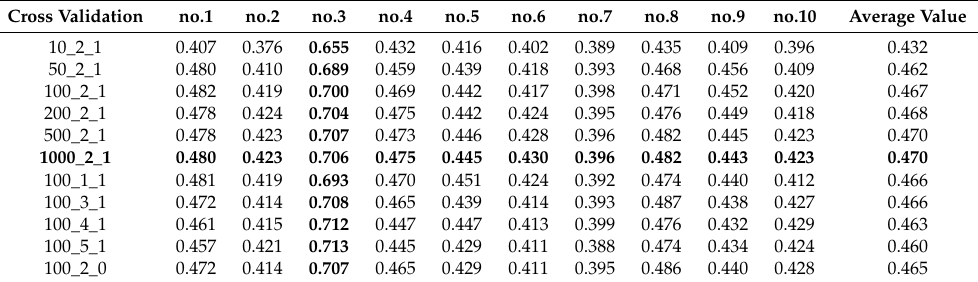
Table A3. Results using different parameters in the RF